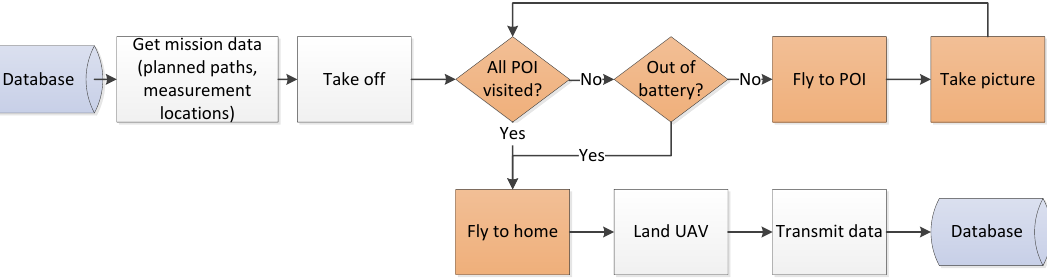
Figure 5. Algorithm for autonomous information gathering. Orange boxes indicate algorithm steps in which the UAV is gathering information and is, therefore, not connected to the base station. White boxes indicate steps in which the UAV shall be connected to the base